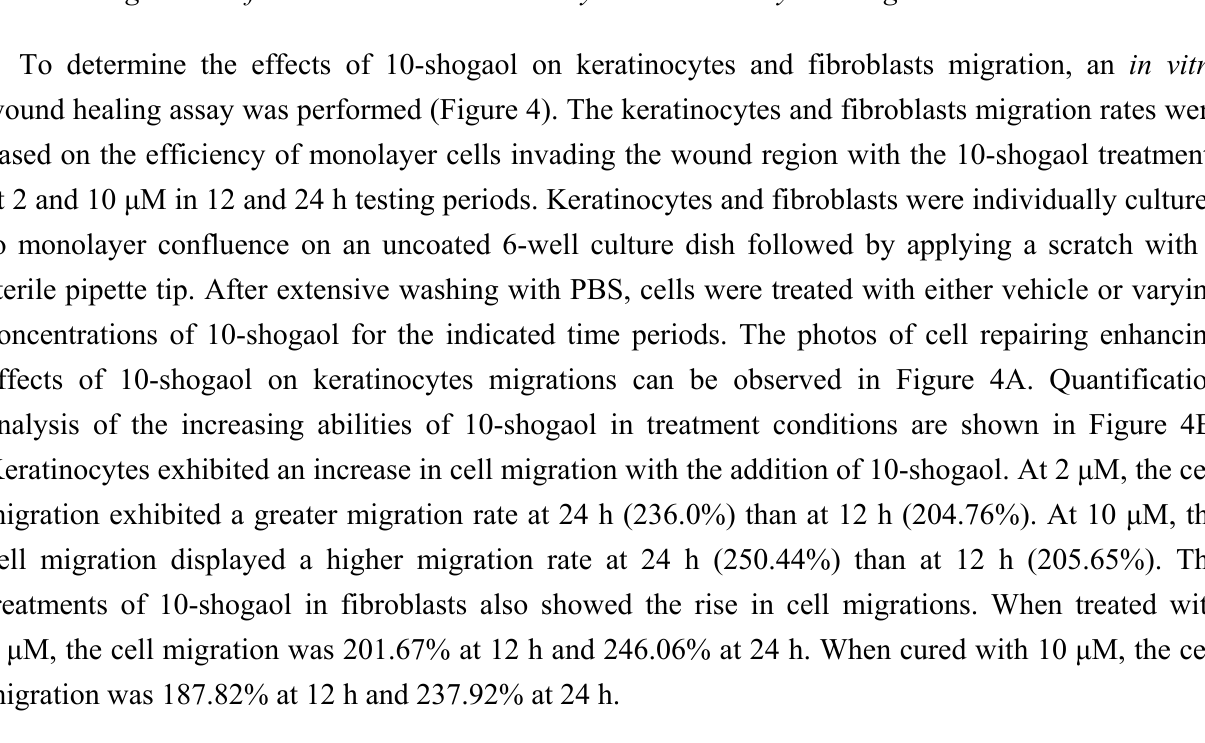
Figure 4. In vitro wound healing assay on 10-shogaol effects on human skin cells. ( A ) Migratory photographs of human keratinocytes; ( B ) Quantification of the migration potential of 10-shogaol- or PBS-treated cells; ( C ) Photographs of fibroblasts; ( D ) Fibroblasts migration quantifications. The data was shown as mean ± SD of three independent experiments. Significance for three different time-point groups was accepted at * p < 0.05 versus their corresponding